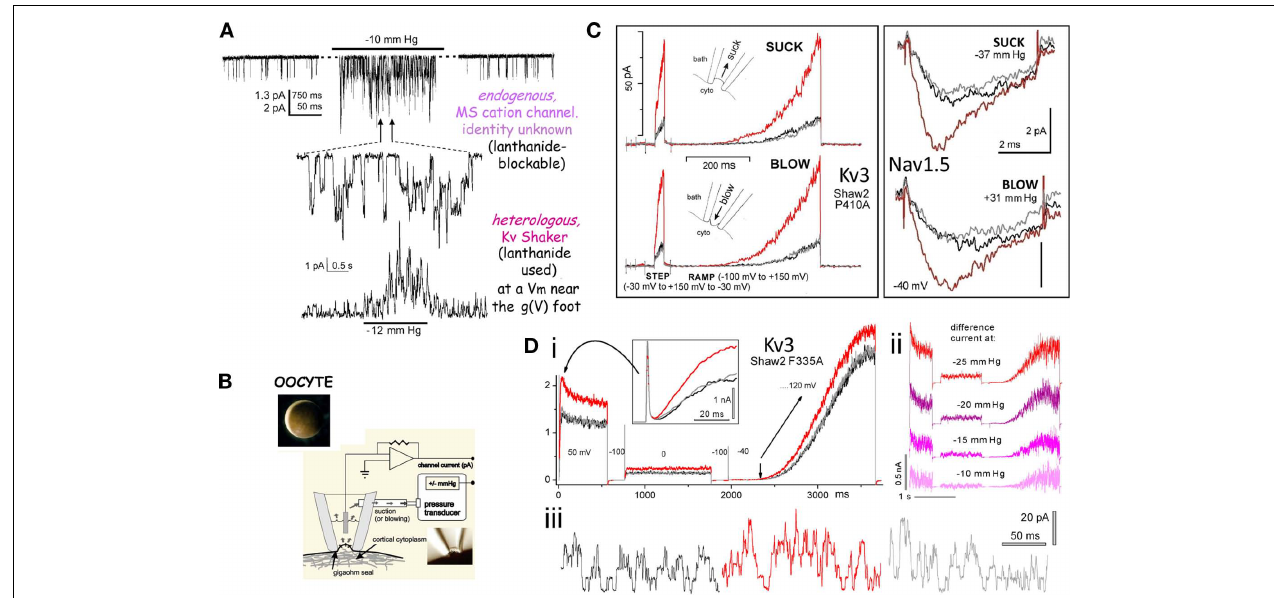
positive (“blow”), as seen for two very differentVGCs, a Kv3 homotetramer and a Nav1.5 pseudotetramer. Multivalent lanthanide ions included in the pipette inhibit endogenous stretch channel activity (and, as expected, right-shiftVGC currents by tens of mV). Here, and throughout, black, red, gray traces signify before, during, after stretch. (Di,ii) Illustrates “stretch difference currents” obtained from before/during/after records (two step depolarizations and one ramp depolarization are used here) and demonstrates that the magnitude of the stretch difference currents increase with increasing stretch intensity, while (iii) shows that stretch increases unitary K currents frequency at 0mV (which corresponds to the reversal potential of endogenous stretch-activated cation channels).These figures are modified from (Gu et al., 2001; Laitko et al., 2006; Morris and Juranka,